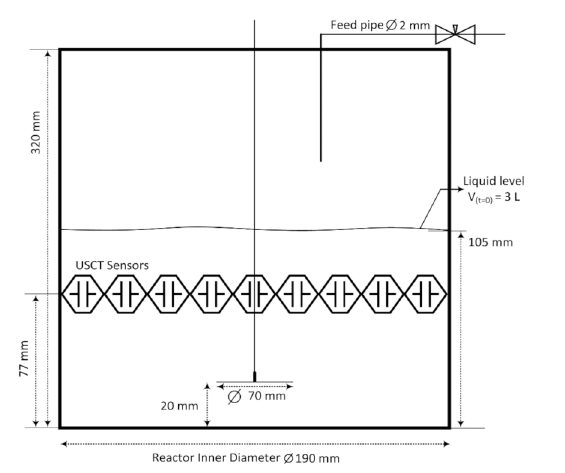
Figure 3. Schematics of the experimental setup. Dimensions of the plexiglass reactor and position of the USCT sensors. The initial solution volume in the tank is 3 L.